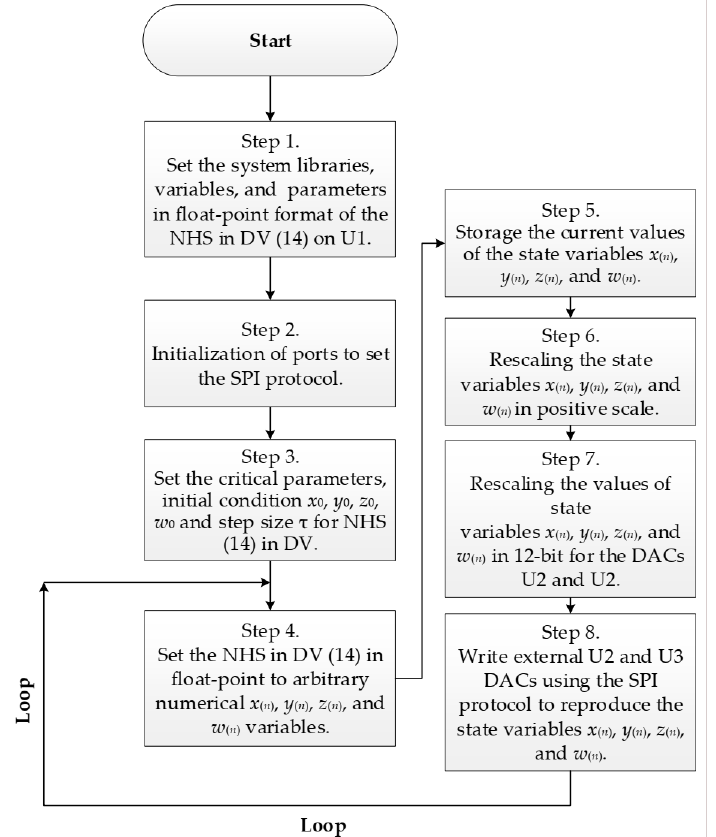
Figure 9. Flow chart of the electronic/digital implementation process in floating-point version of NHS